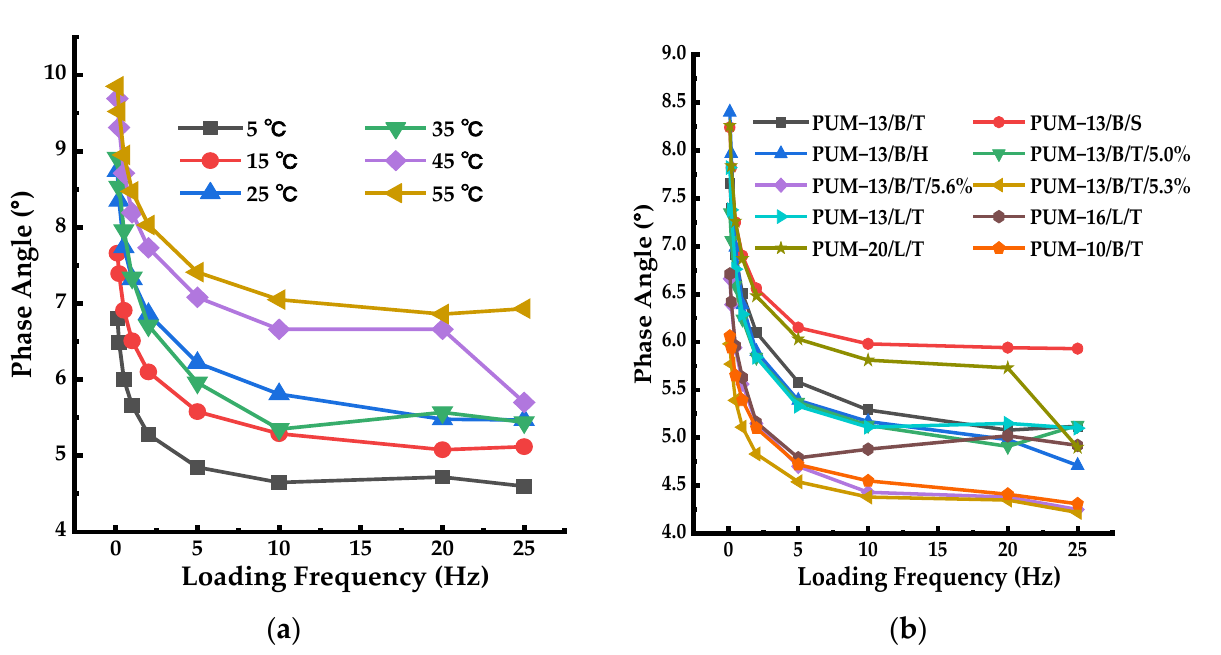
Figure 3. The phase angle of the PU mixtures. ( a ) PUM − 13 at different test temperatures and loading frequencies. ( b ) Different PU mixtures at 15 °C.